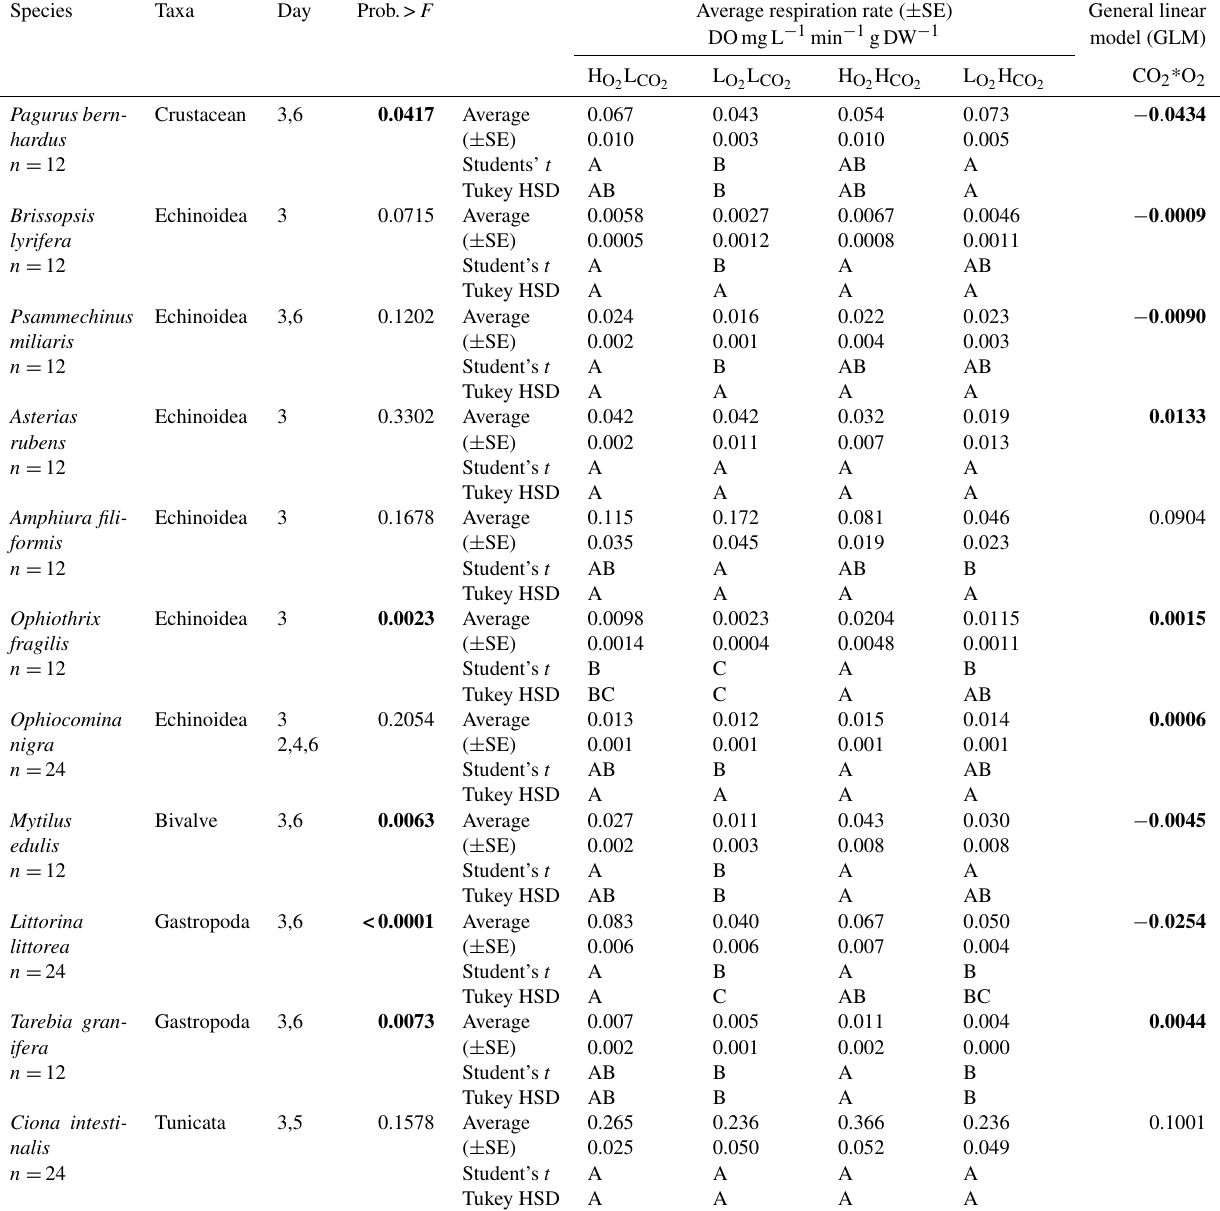
Table 3. Respiration Rate in DOmgL − 1 min − 1 gDW − 1 ( ± SE) and results of the general linear model (GLM) of all tested species (pooled data where we had data from different days). Levels not connected by the same letter are significantly different (after Student’s t and Tukey HSD tests). Numbers written in bold colour highlight significant